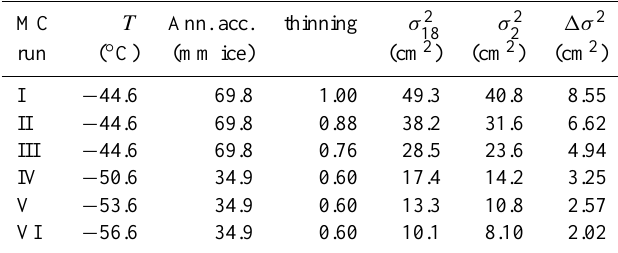
Table 1. Climatological and glaciological parameters used in the different Monte Carlo runs. The firn temperature, annual accumulation and thinning are input values, leading to the (differential) diffusion lengths given in the last three columns. MC Ann. acc.